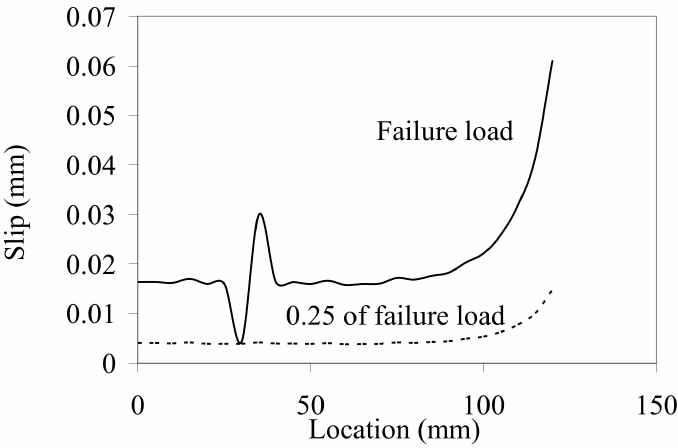
Figure 15. Interfacial slip distributions for specimen